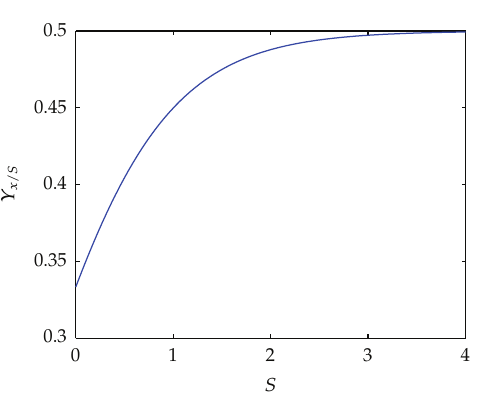
(cid:7) 0 . 5 and the cell sensitivity to the substrate equals 1 . 5 (cid:5) i.e., a (cid:7) 2, max